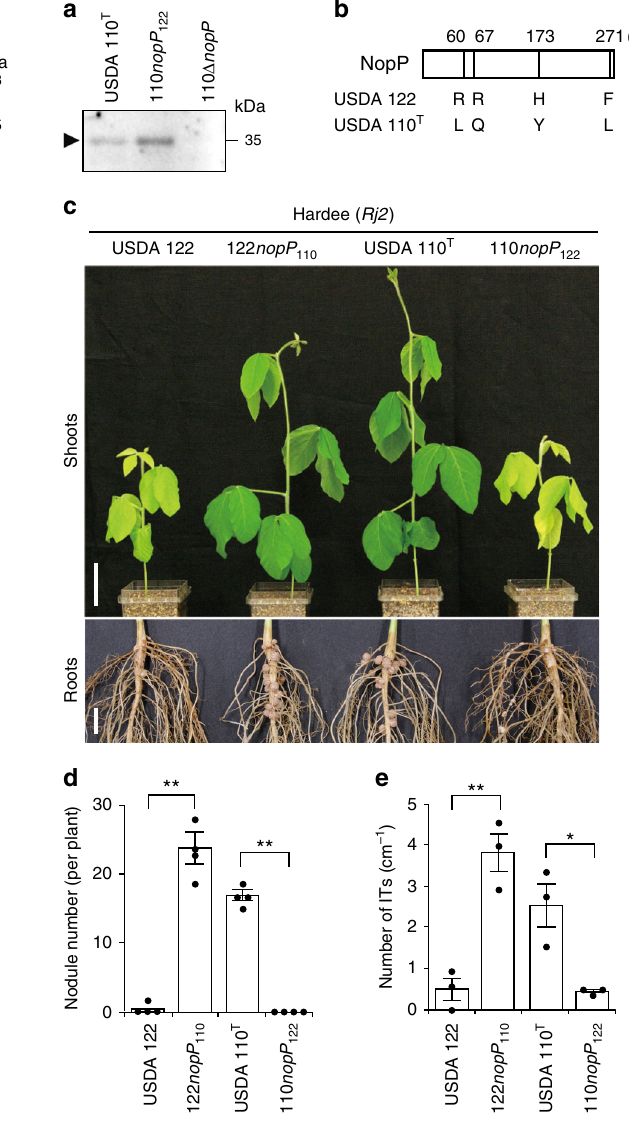
Fig. 4 Effect of nopP swapping between USDA 122 and 110 T on symbiosis with Hardee. a Western blotting analysis of NopP secreted into culture supernatants from USDA 110, 110 nopP 122 , and nopP deletion mutant of USDA 110 T (110 Δ nopP ). Strains were grown in the presence of 10 μ M genistein. The position of NopP is indicated by arrow. b Differences in amino acid residues in NopP between B. diazoef fi ciens USDA 122 and 110 T . c Shoots and roots of cv. Hardee at 28 days after inoculation with USDA 122, 110 T , or strains with swapped nopP (122 nopP 110 , 110 nopP 122 ). Scale bars, 5 cm (for shoots) or 1 cm (for roots). d Number of nodules formed on roots at 28 days after inoculation. The data shown are representative of three independent experiments. Error bars show SEM ( n = 4). e Number of infection threads (ITs). ITs were counted on whole region of main roots at 2 days after inoculation. Error bars show SEM ( n = 3). * P < 0.05, ** P < 0.01 by two-tailed Student ’ s t